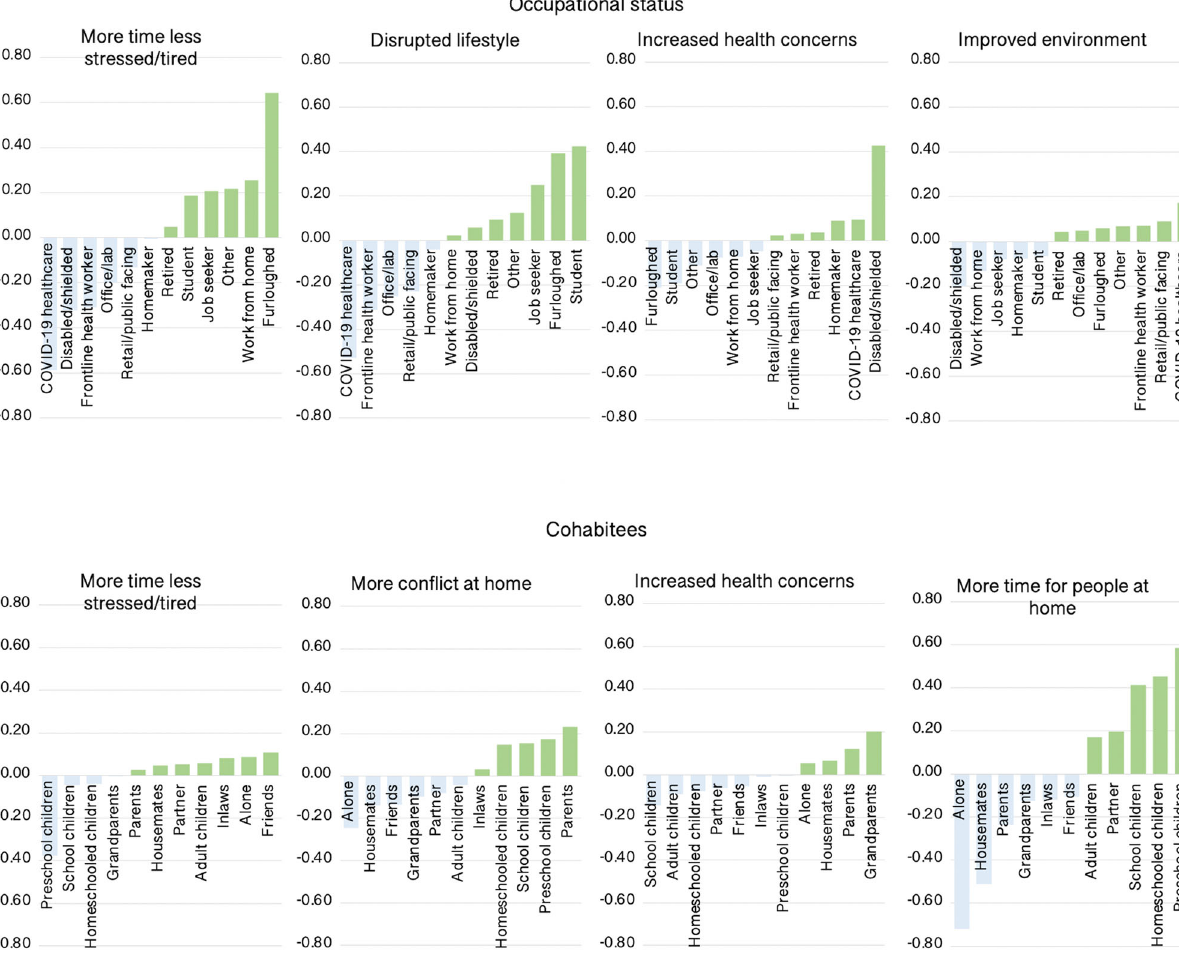
Fig. 7 Self-perceived pandemic impact by occupational status and cohabitees. There were medium – large-scaled associations between occupational status and cohabitees with self-perceptions of the ways that they had been affected by the pandemic. Y axes = mean centred GLM parameter estimates when predicting component scores (SD units). Source data are provided as a Source data fi